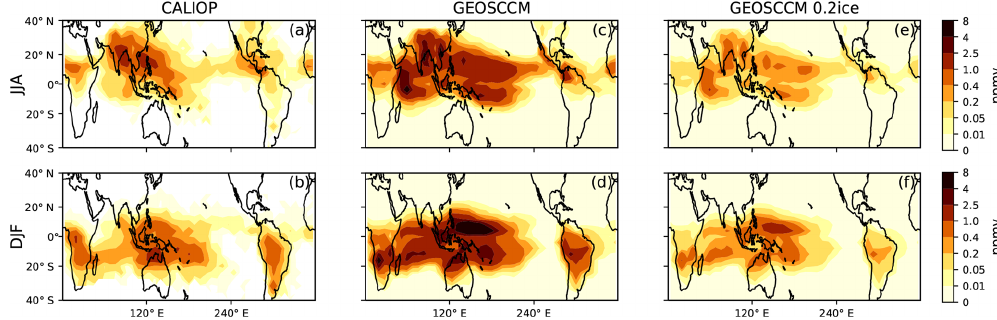
Figure 4. Same as Fig. 3 but for convective IWC (ppmv) averaged between 121 and 82.5hPa during JJA and